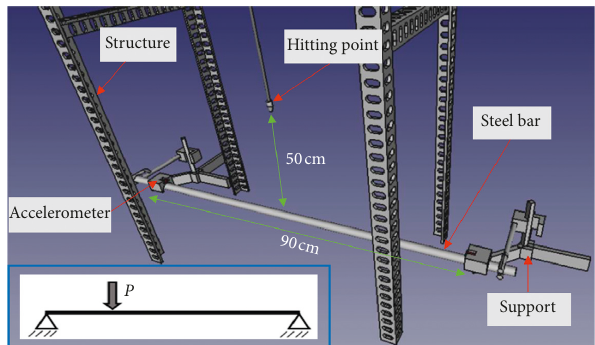
Figure 2: Design in FreeCAD 3D of the hitting equipment and the scheme of the